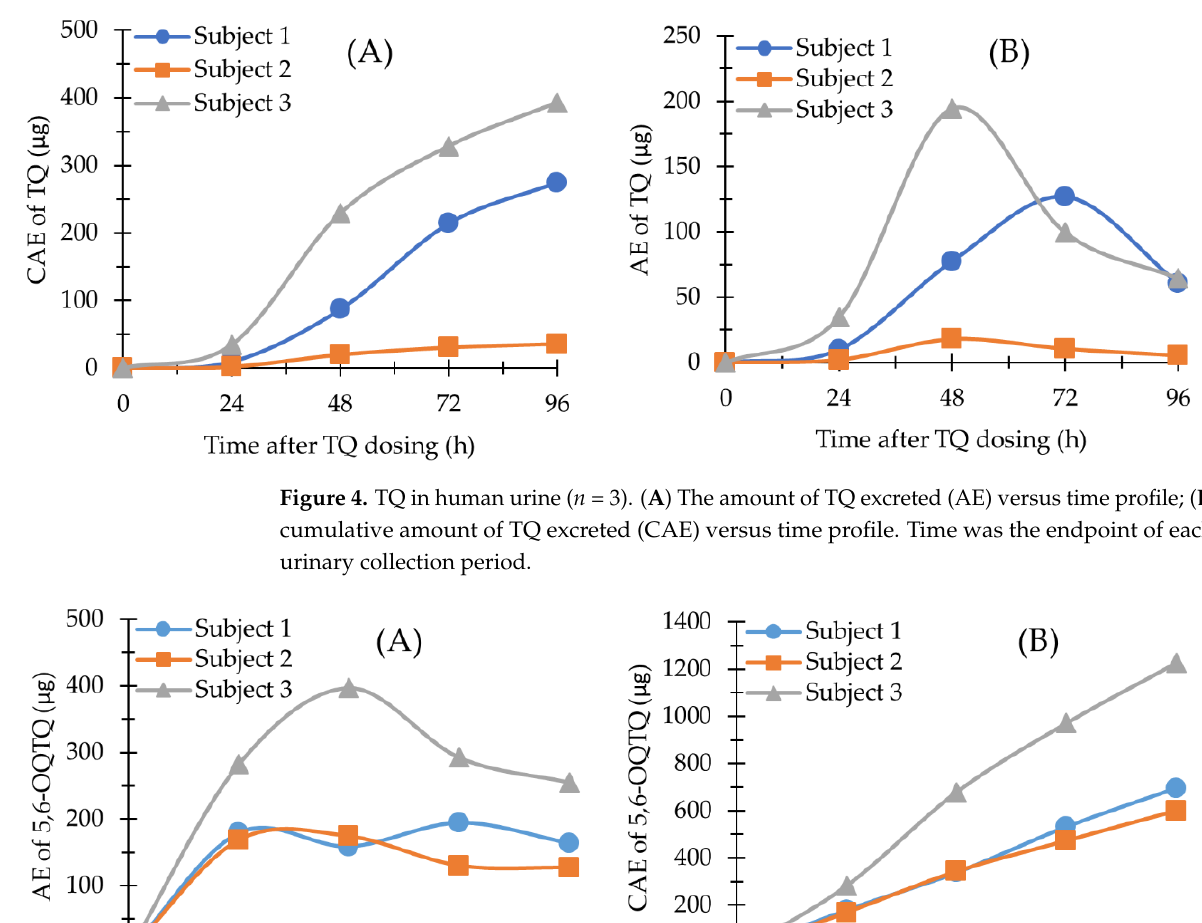
Figure 3. TQ concentration — time profiles in human plasma ( A ) and human blood ( B ) from three subjects given 200 mg TQ orally; Subject 1, (circle line); Subject 2, (square line); Subject 3, (triangle line).